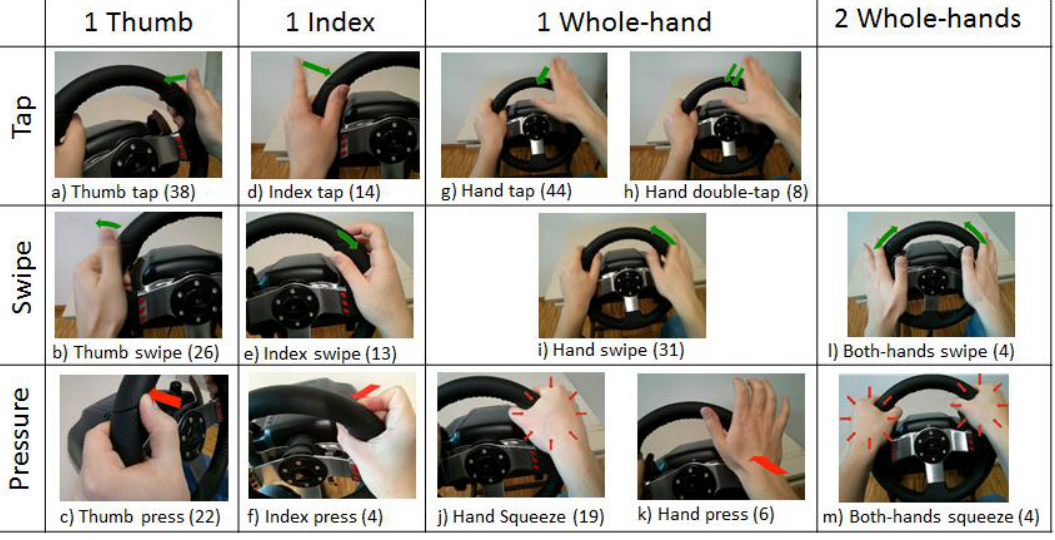
Figure 9. User-elicited gesture taxonomy for the WheelSense